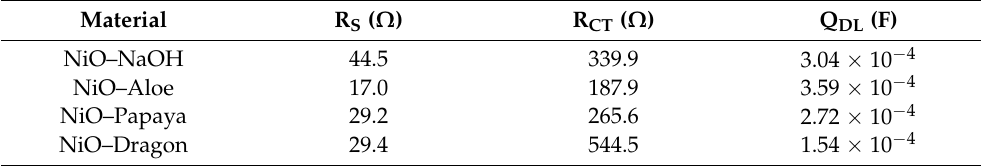
Table 4. Equivalent circuit fitting parameters for the EIS